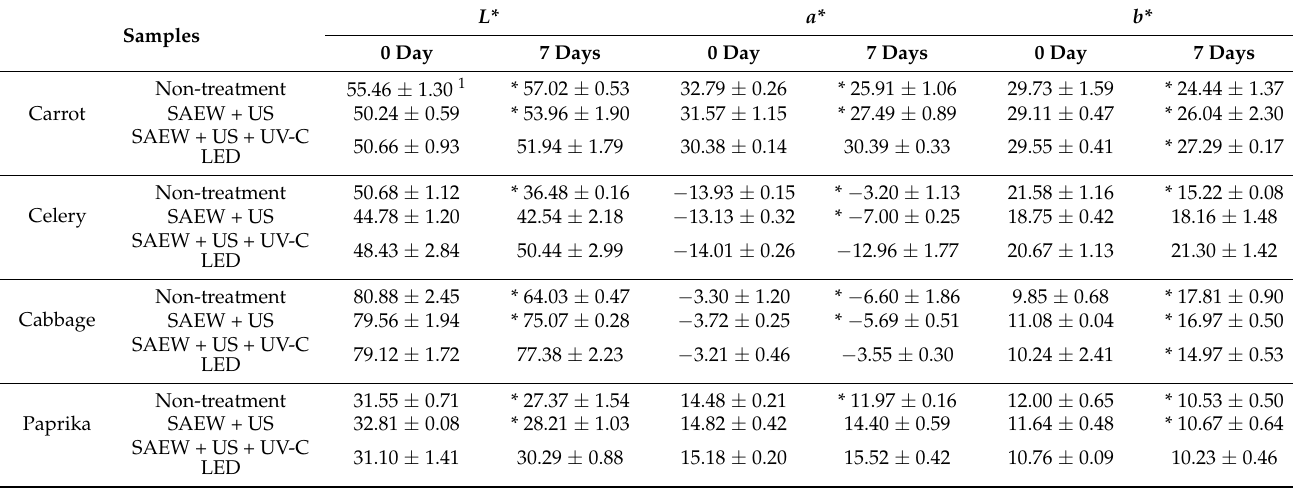
Table 4. Effect of combined treatments on hunter color values in fresh-cut vegetables after storage for 7 days at 15 ◦ C.